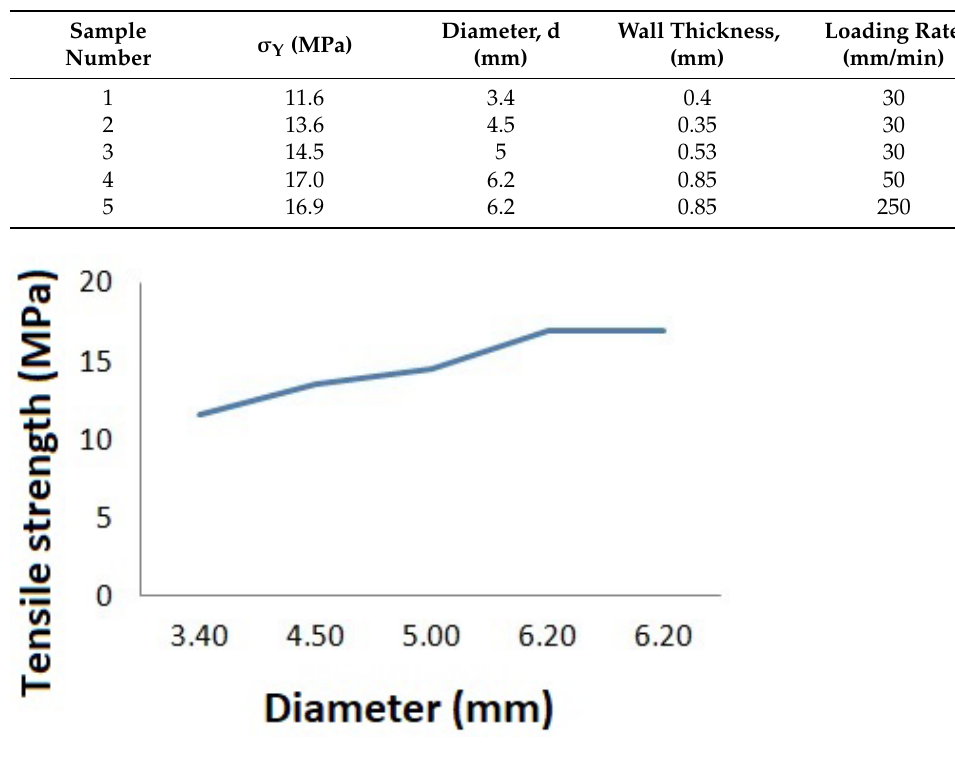
Figure 3. Stress–strain diagram by specimen rupture test.